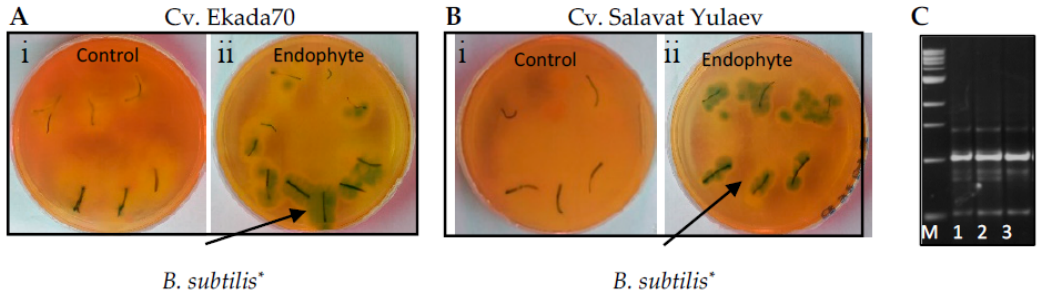
Figure 1. The ability of Bacillus subtilis 10-4 (endophyte) to colonize internal tissues of surface-sterilized wheat plants. Two cultivars were tested: cv. Ekada70 (drought-tolerant)) ( A ) and cv. Salavat Yulaev (drought-sensitive) ( B ). i —the absence of B. subtilis bacteria growth around the surface-sterilized root and leaf segments in non-inoculated wheat seedlings (Control); ii — B. subtilis bacterial growth (* light green to green colonies) around the surface-sterilized leaf and root segments of wheat seedlings pre-inoculated with B. subtilis 10-4 (Endophyte); ( C )—electrophoregram of PAAG: M—DNA marker; 1—DNA of origin B. subtilis 10-4, used for pre-sowing inoculation of seeds; 2 and 3—DNA of bacteria grown around wheat plant segments. Black arrows indicate B. subtilis growth (light green to green colonies) around the plant segments. Each variant was performed in three replicates, 10 seedlings per replicate.